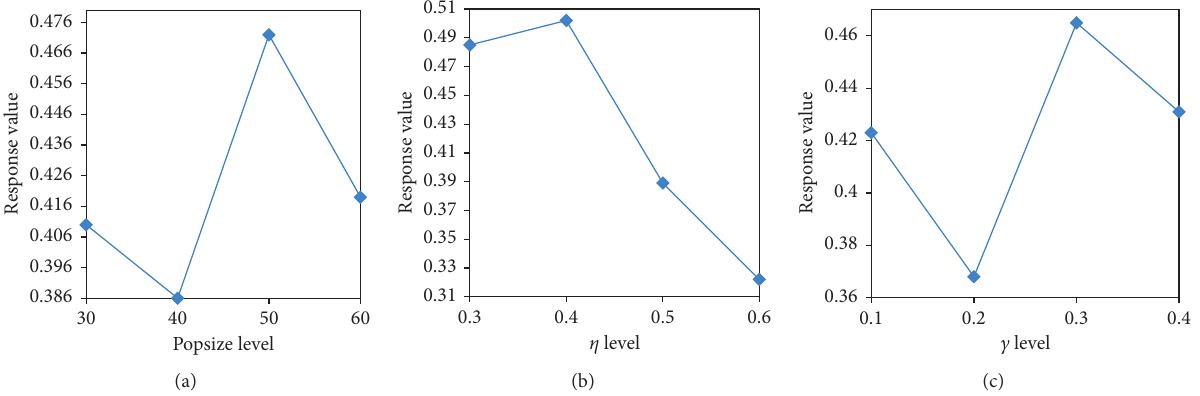
Figure 6: The level trend of the influence of each parameter on the algorithm performance.